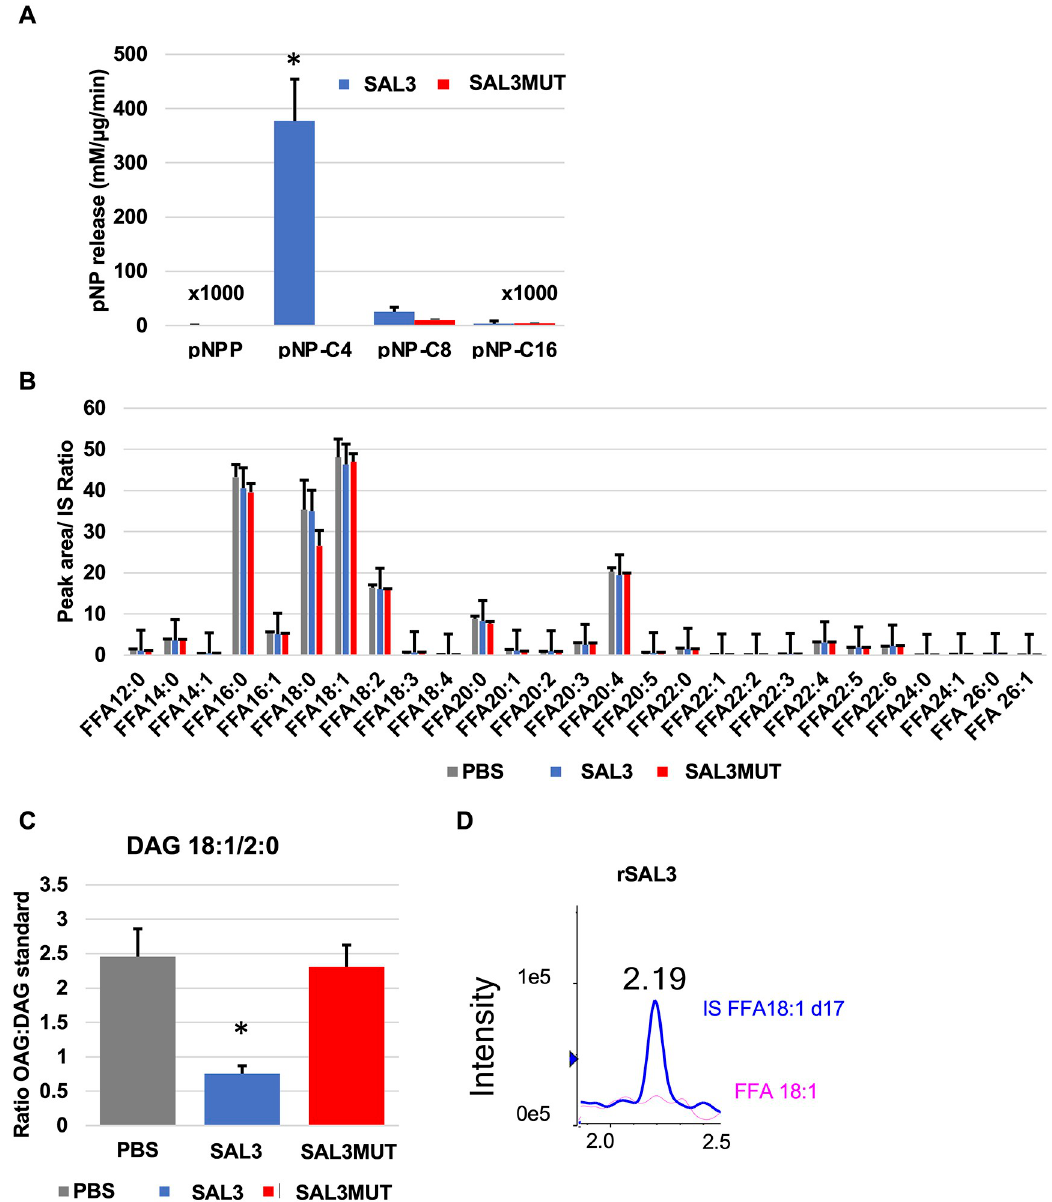
Fig 4. Fatty acid chain length specificity of SAL3. A. Specific activity of 10 μ g rSAL3/mL (0.25 μ M) and 10 μ g rSAL3MUT/mL (0.25 μ M) for hydrolysis of paranitrophenol esters with fatty acids of increasing chain length: pNPP (paranitrophenol phosphate), pNP-C4 (paranitrophenol butyrate), pNP-C8 (paranitrophenol octanoate), pNP-C16 (paranitrophenol palmitate). Error bars represent standard deviation of reactions carried out in triplicate. B. Analysis of free fatty acid release from bovine heart extract micelles by 10 μ g rSAL3/mL (0.25 μ M) or 10 μ g rSAL3MUT/mL (0.25 μ M)/mL (0.25 μ M). Recombinant proteins were in PBS and PBS alone was used as a control C. Hydrolysis of 2 μ g 1-oleoyl 2-acetyl glycerol (OAG)/mL by 80 μ g rSAL3/mL (2 μ M). The y-axis shows the ratio between OAG and the internal standard DAG 15:0–18:1(d7). D. The red line shows that there was no detectable release of free oleic acid (FFA 18:1) in the reaction from panel C. An internal standard is shown in blue and was included as a reference for retention time. The x-axis is indicative of the retention time in minutes.